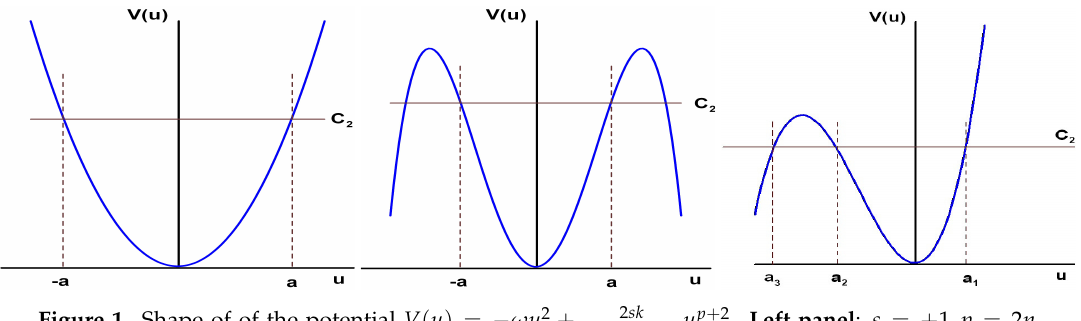
Figure 1. Shape of of the potential V ( u ) = − ω u 2 + 2 sk Middle panel : s = − 1, p = 2 n . Right panel : s = + 1, p = 2 n +